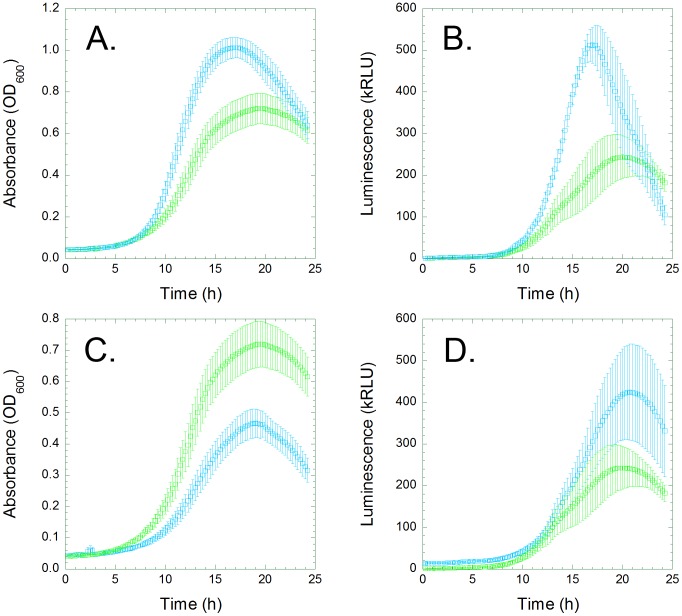
The lux/ΔthrL and lux/ΔhyfC strains exhibit improvements over the parental lux/BW25113.Each strain was propagated (N = 6) for 24 hours in M9 medium supplemented with ampicillin and IPTG in a Biotek Synergy2 plate reader (37°C, medium shaking); the OD600 and luminescence were recorded from each culture every 15 minutes. The lux/ΔthrL strain (blue squares, A) grows more quickly and to higher cell density than does the lux/BW25113 (green squares), and produces more light (B). The lux/ΔhyfC transformant grows more slowly the parental control (C), but produces more light (D).